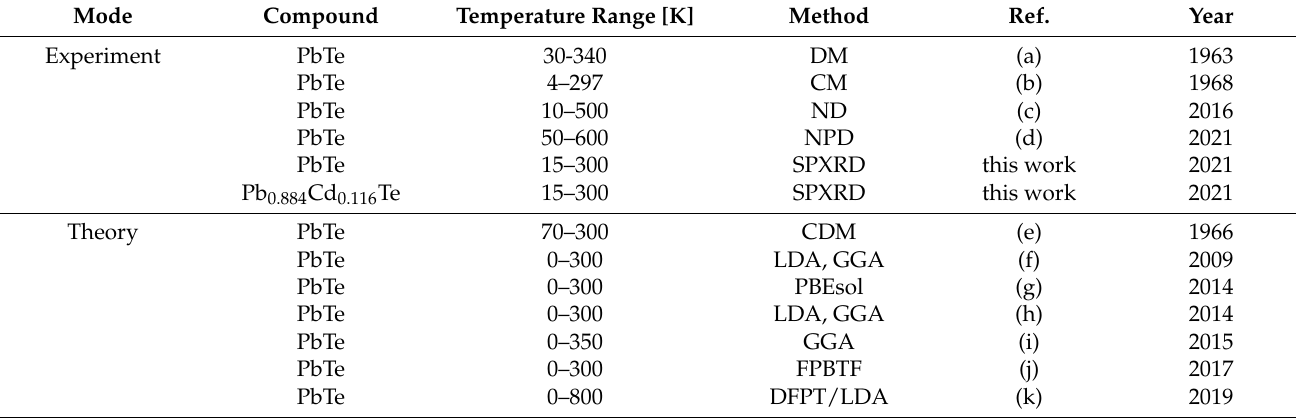
Table 3. Temperature ranges for selected experimental and theoretical studies on the variation of the linear thermal expansion coefficient, α ( T ), of PbTe and Pb 1 − x Cd x Te ( x = 0.116). In the case of the experimental studies, the ranges refer to the lower and upper limit of the experiment.